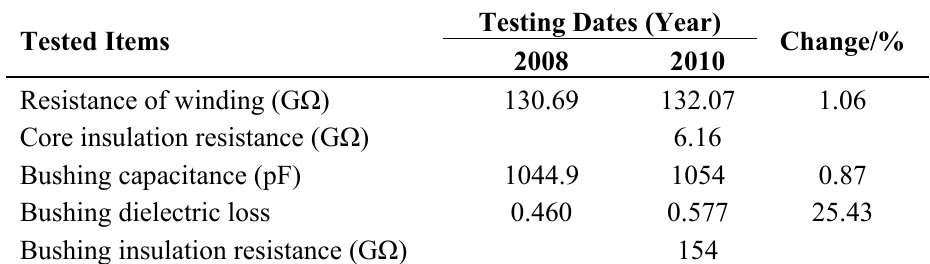
Table 4. Preventive test results.